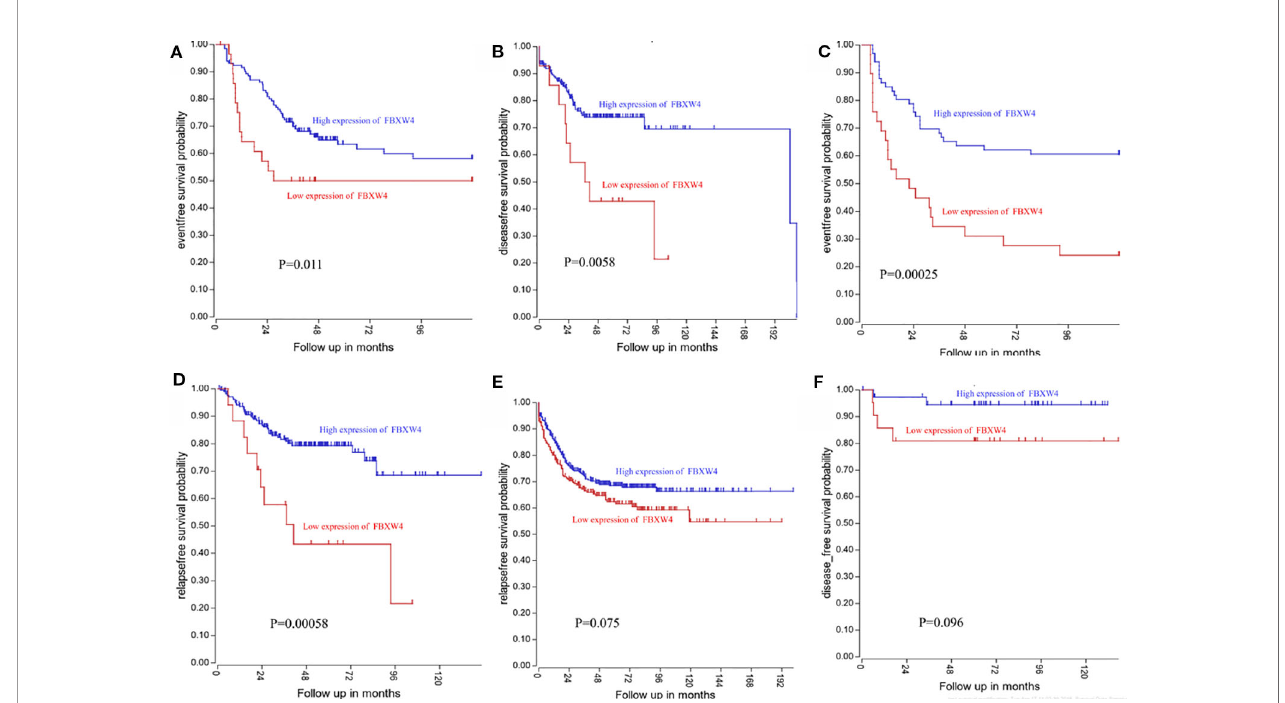
FIGURE 5 | Low FBXW4 expression was correlated with a worse event-, disease-, and relapse-free survival. (A – D) Low FBXW4 expression was correlated with a signi fi cantly worse event-, disease- and relapse-free survival. (both P < 0.05). (E) (P = 0.075) and (F) (P = 0.096) Low FBXW4 expression was correlated with a worse disease- and relapse-free